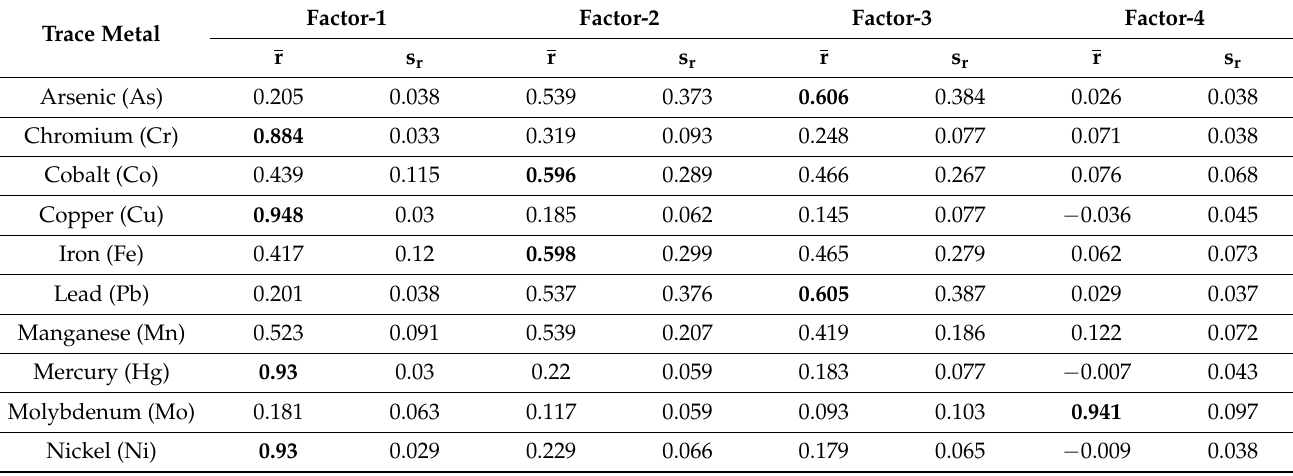
Table 11. Combined log-normal simulation and resampled Syracuse trace metal analytical error varimax-rotated factor dimensions: census tract averaged soil sample data (10,000 replications).